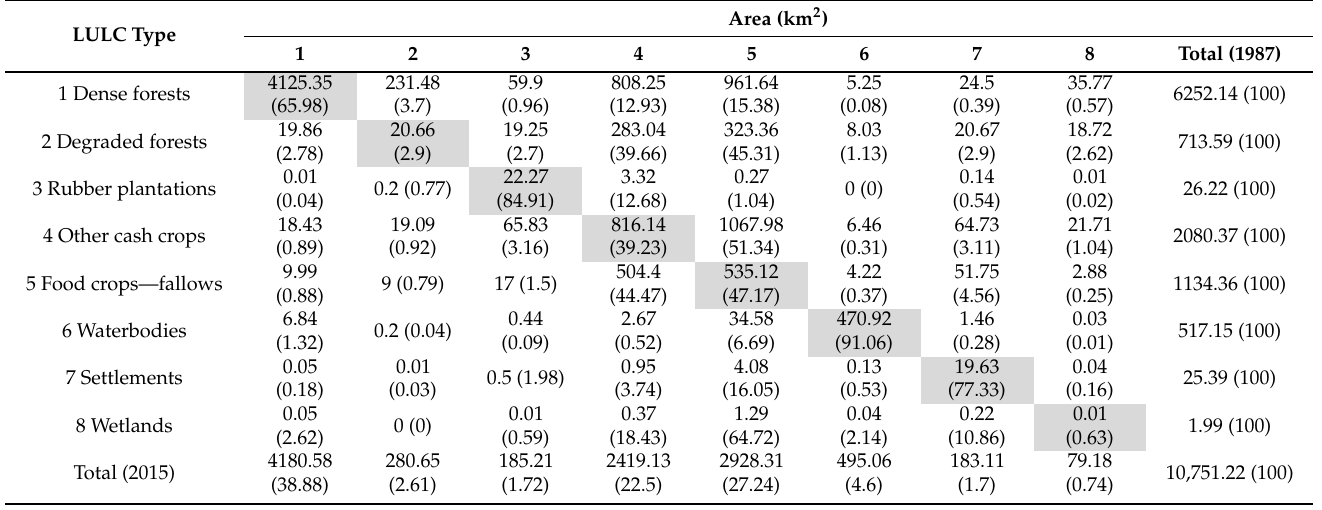
Note: grey cells on the diagonal represent unchanged LULC areas and from 1987 to 2015 and their corresponding percentages in parenthesis, while off-diagonal cells are the areas changed from one class to